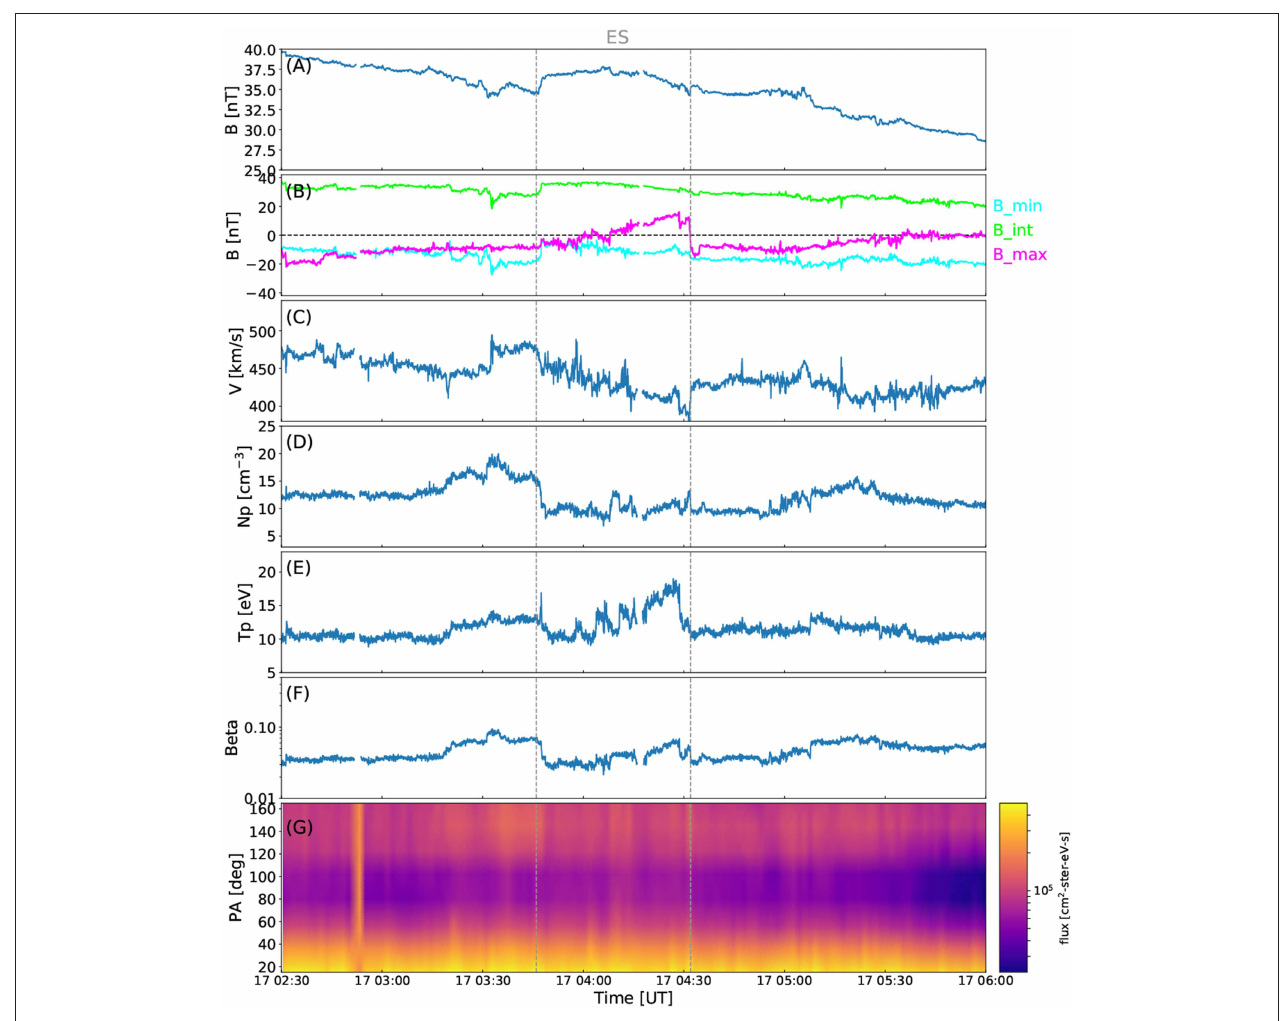
FIGURE 7 | The embedded substructure (ES) in FR3 observed at Earth’s L1 point. The ES is bounded by the vertical dashed lines. The panels show, from top to bottom: (A) magnetic field magnitude, (B) magnetic field components in MVA coordinates (light blue: B min , lime: B int , pink: B max ), solar wind (C) speed, (D) density, (E) temperature, (F) plasma beta, and (G) the pitch angle spectrogram of suprathermal 255 eV electrons. The 3 s IMF and solar wind plasma data are from the Wind